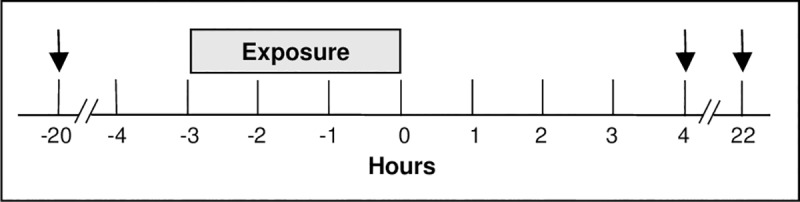
Timeline for each exposure session.